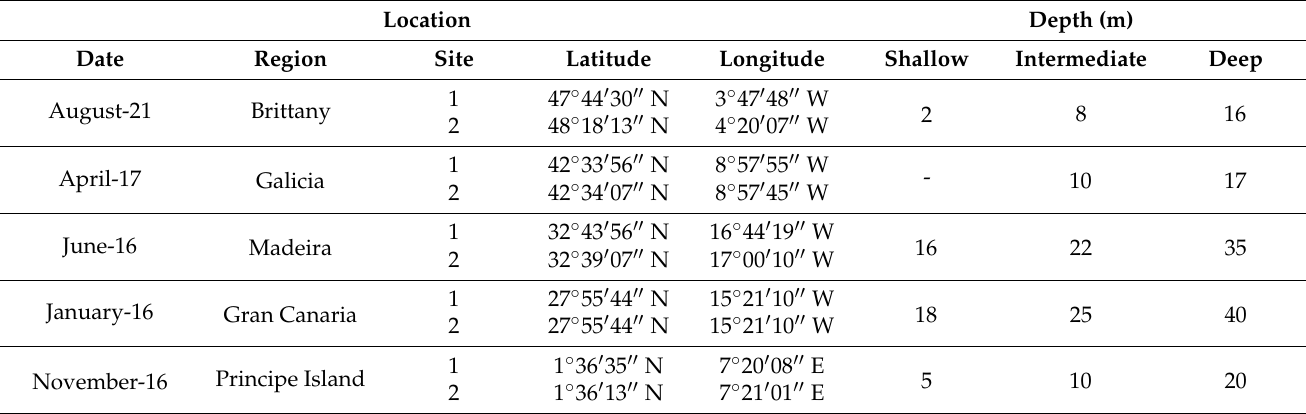
Table 2. Date, location (latitude and longitude), and depth (meters) that corresponded to each rhodolith seabed. Between location, the depths (m) of each stratum (i.e., shallow, intermediate, and depth) were different, since in each location, the rhodolith seabeds have a different vertical